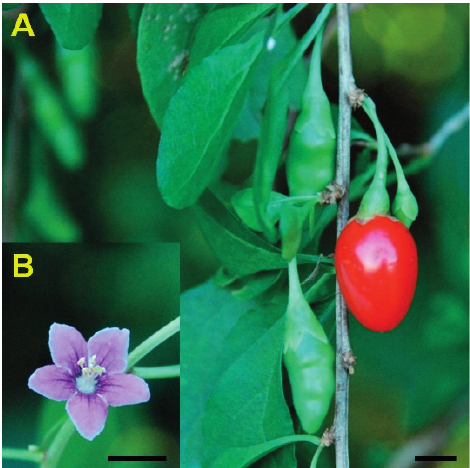
Figure 1. Fruits ( A ) and flower ( B ) of Lycium chinense . Bar = 0.5 cm.